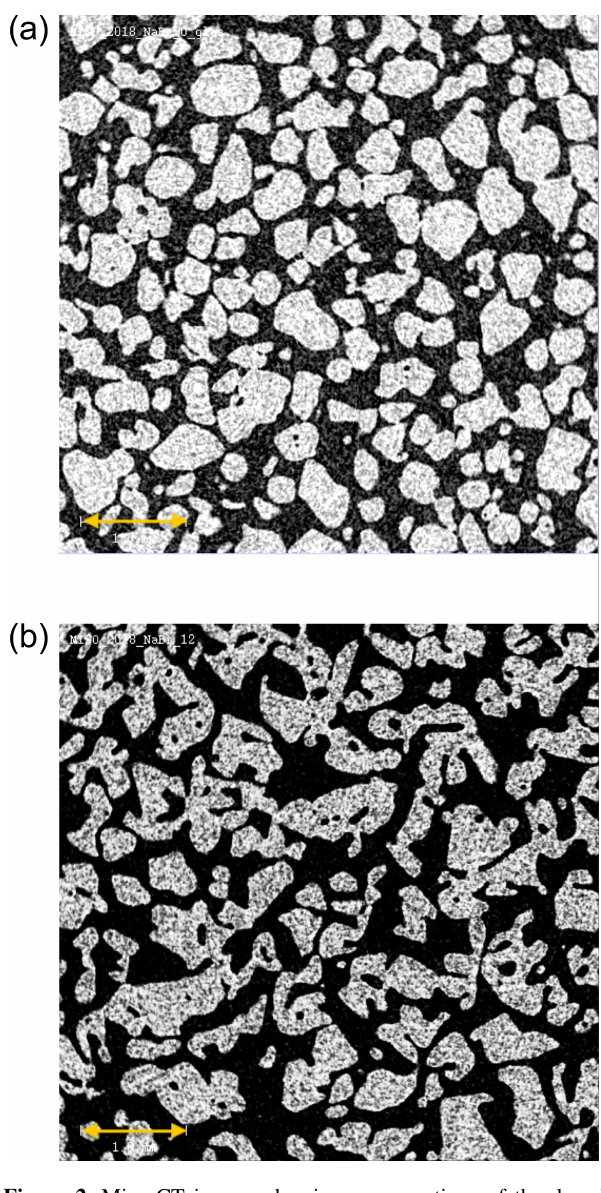
Figure 2. MicroCT images showing cross sections of the doped snow samples after 0d (a) and 12d (b) exposure to temperature gra- dient metamorphism. White areas show the ice phase, and black rep- resents interstitial air. The scale bar (yellow arrow) denotes